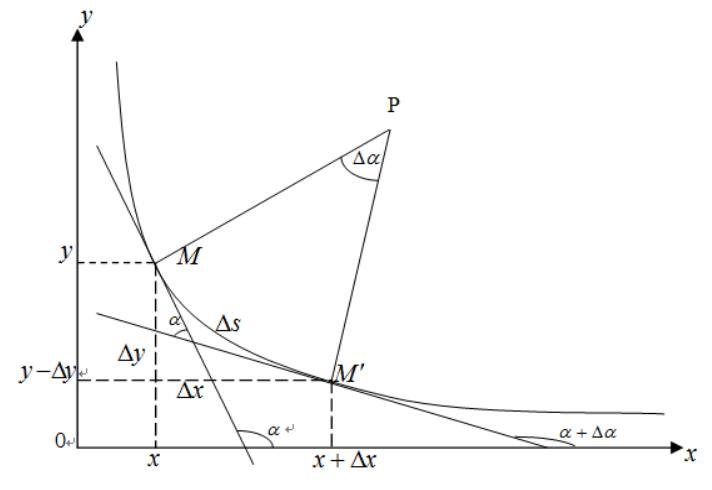
Figure 2. Power law function curvature. 142